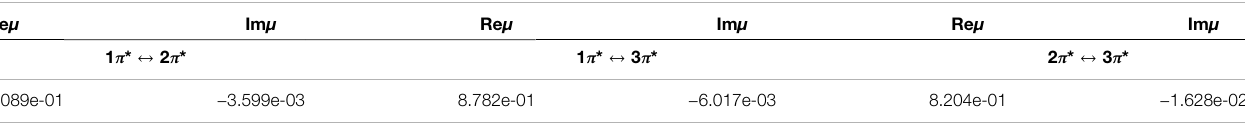
TABLE 4 | Complex dipole transitions (in a.u.) between the three lowest shape-type resonances of the uracil anion calculated with RVP. Electronic-structure method: EOM- EA-CCSD. Basis set: cc-pVTZ+2s2p2d. Reprinted from Ref. [66], with the permission of AIP Publishing. Re μ Im